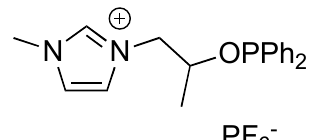
Figure 17. Phosphinite functionalized